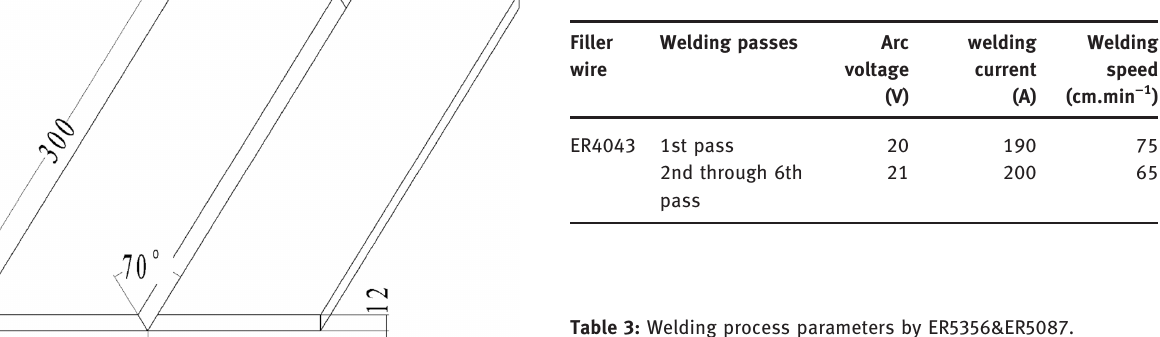
Table 2: Welding process parameters by